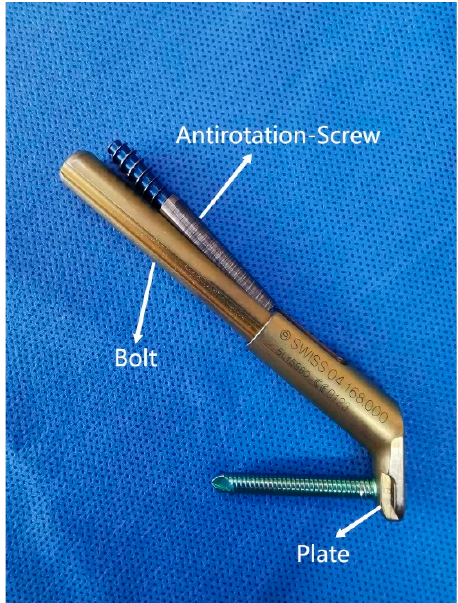
Figure 1. The FNS consists of three parts: the plate and locking screw in the angular stable structure (neck shaft angle = 130°); the bolt (diameter = 10 mm); the anti-rotation screw (diameter = 6.4 mm, branched out from the base of the bolt at an angle of 5°).